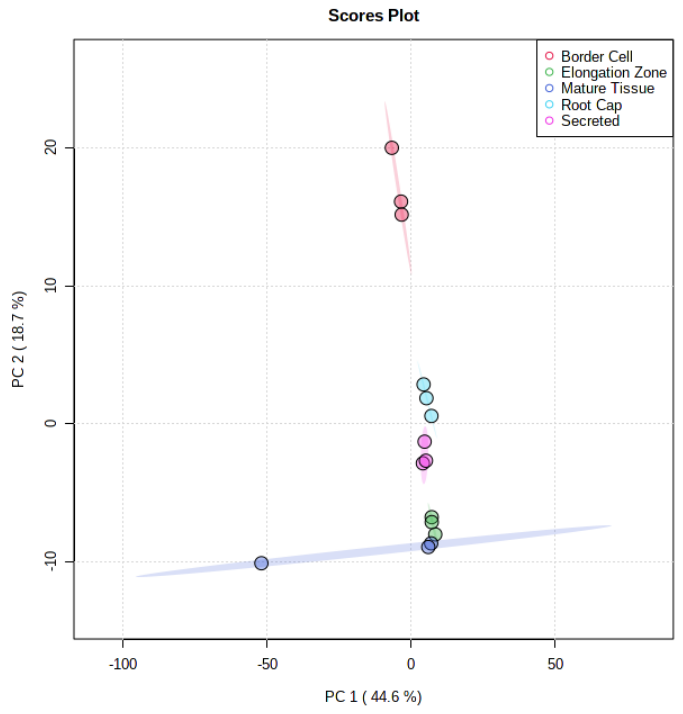
Figure 3. Principle Component Analysis of UHPLC-MS Analyzed Fractions. Comparison of all five fractions indicates a 44.6% variance in the first principle component and 18.7% variance in the second component. The spatial separation of fractions indicates differential localization of metabolites.